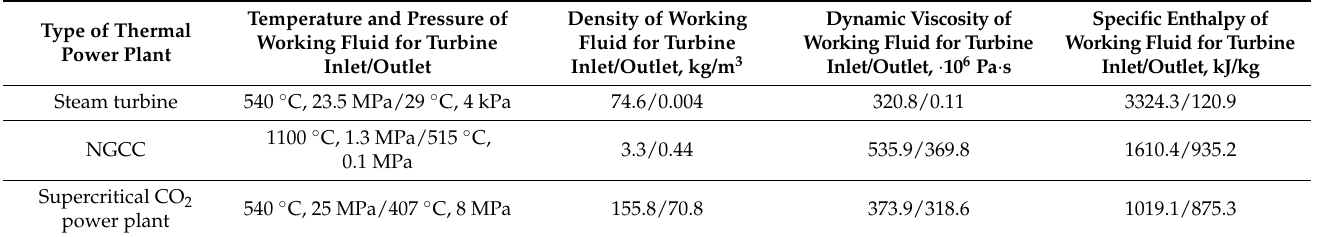
Table 1. Thermophysical properties of water, air and supercritical carbon dioxide within the typical parameters of modern gas turbine and steam turbine